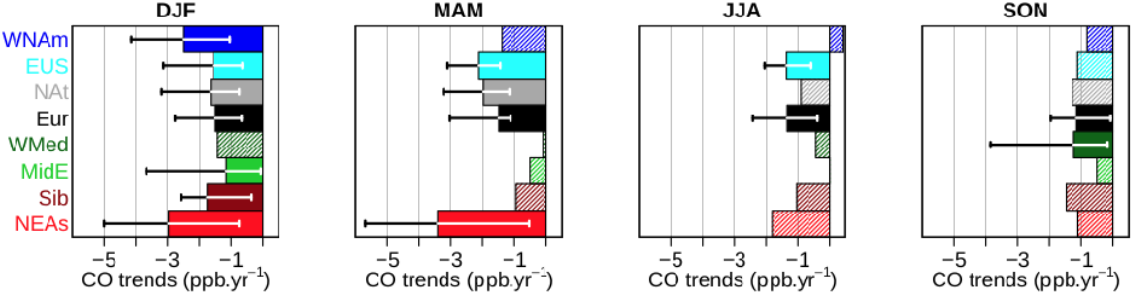
Figure 14. CO trends (ppbyr − 1 ) in the UT in each season. For each significant trend, the error bars represent the 95% confidence interval. The insignificant trends are represented by hatched areas. The coloured labels correspond to the regions defined in Fig. 1.